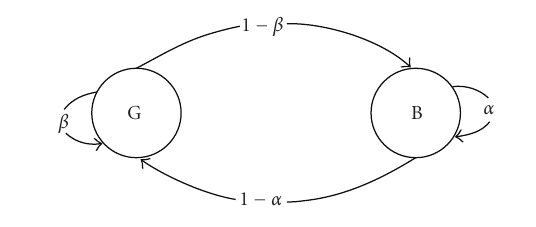
Figure 12: 2-state Markov loss model.